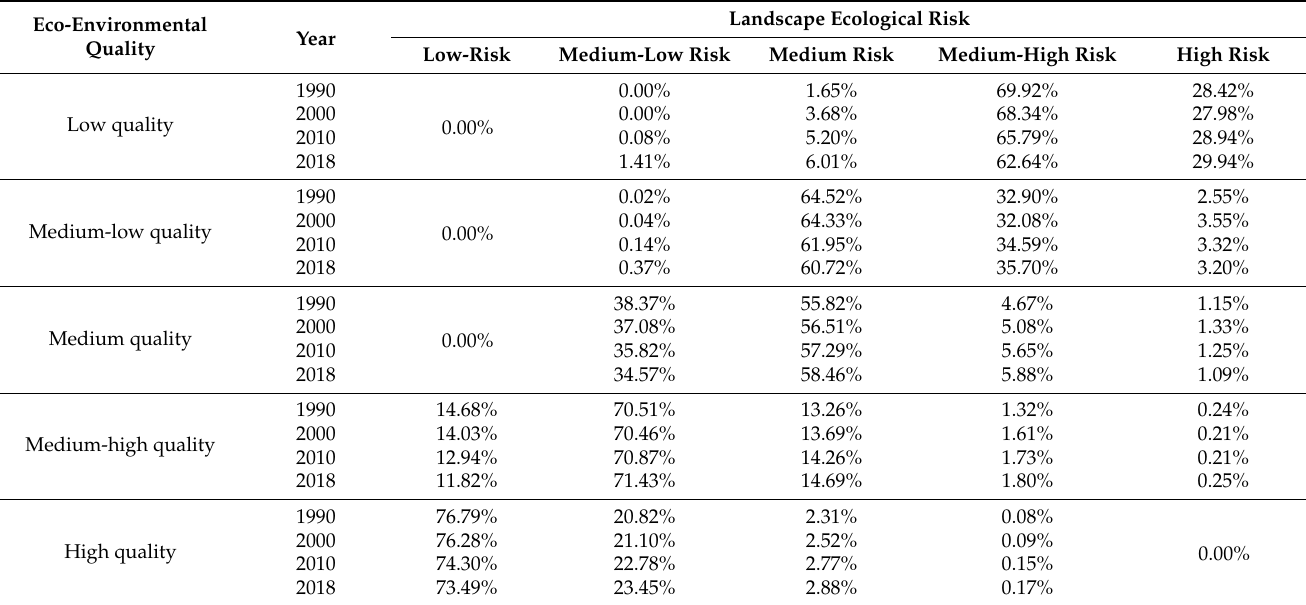
Table 9. Proportion of landscape ecological risk zones in the corresponding eco-environmental quality zones in different